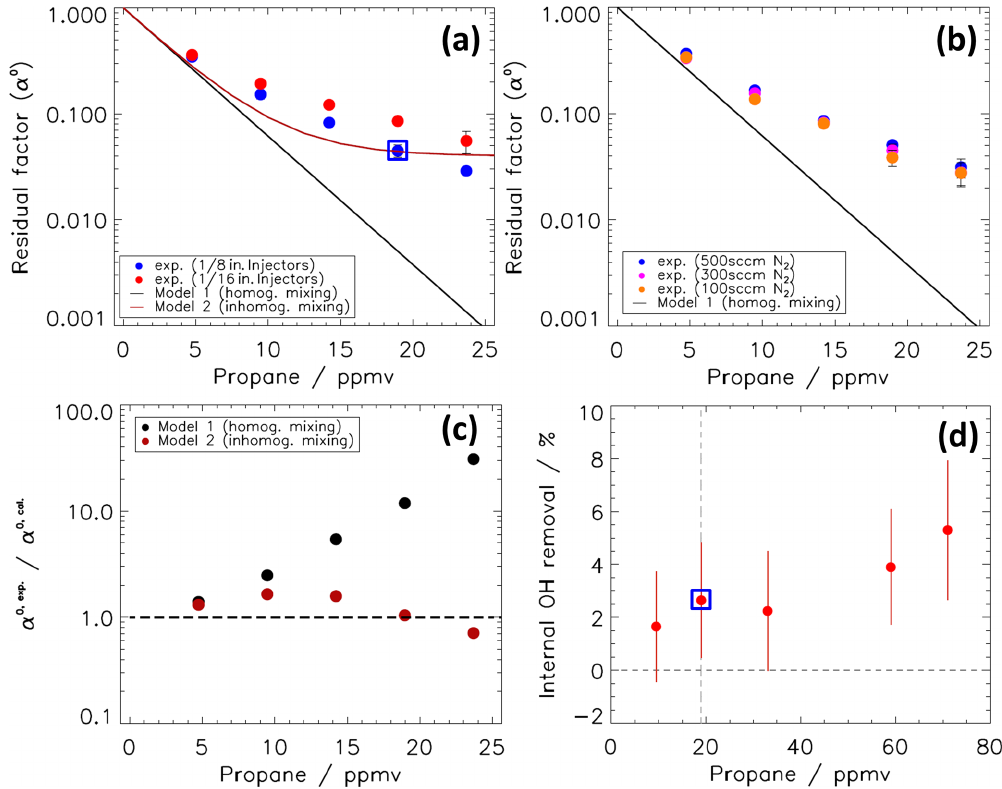
Figure 3. (a) Residual factor ( α 0 ) for OH in a flow of humidified synthetic air running through the CMR. The OH air mixture is provided by a photolytic OH radical source. α 0 is shown as a function of the calculated concentration of propane (at 298K and 1atm), which is injected as a scavenger with 500sccm N 2 into the CMR flow. The experimental α 0 values are shown for two types of injectors with different outer diameters (1 / 8 and 1 / 16in.). The blue open squares indicate the condition used for normal operation in this work. Measurements are compared to calculations assuming either homogeneous or inhomogeneous mixing. (b) Same as (a) , showing measured α 0 values for different injector flow rates. (c) Ratio of experimental and modelled α 0 for the case with 1 / 8in. injectors and 500sccm N 2 injector flow. (d) Measured OH removal by internal scavenging inside the OH detection cell (see